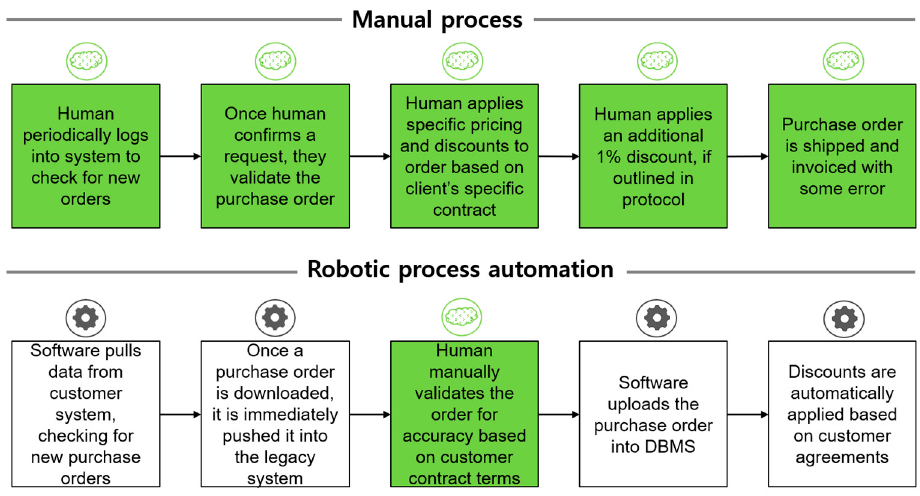
Figure 1. Differences between manual and robotic processes. Adaptation based on Ref. [14,21].